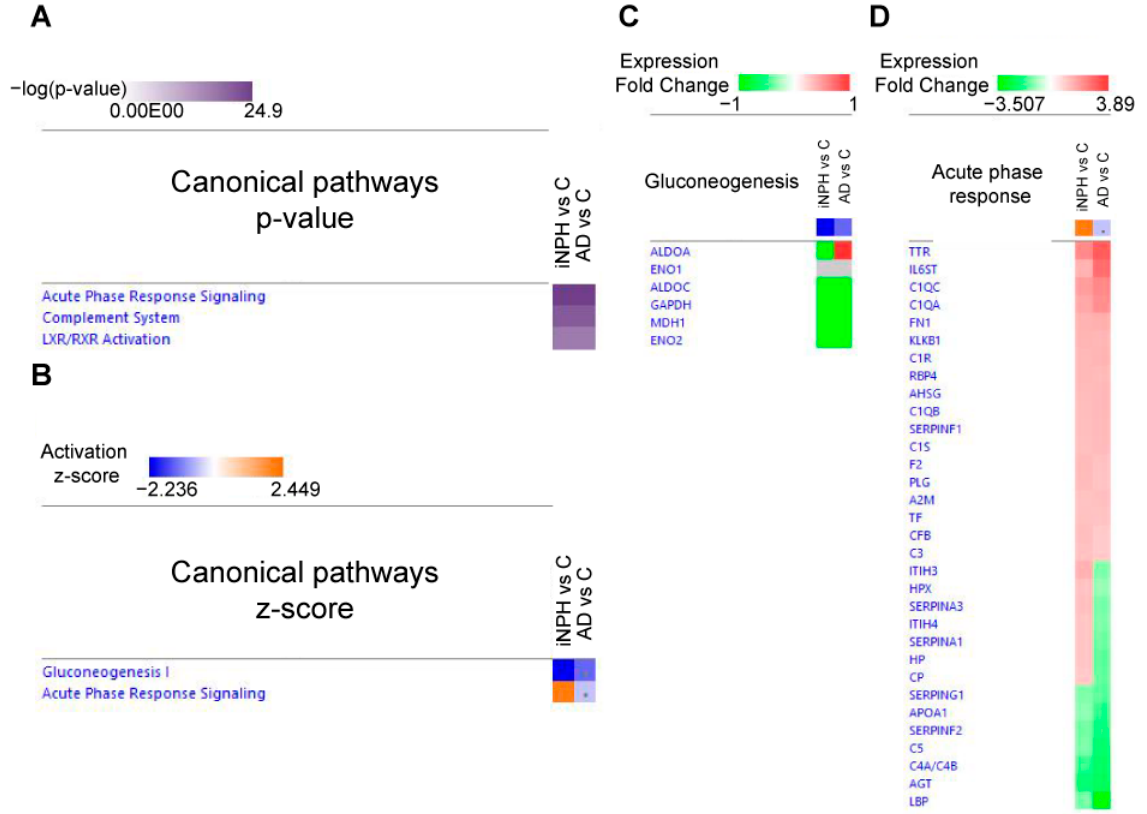
Figure 6. Pathway analysis conducted by IPA software. Canonical pathways were displayed following the p -value ( A ) and the z-score ( B ). Shades of purple from dark to light indicate p -value values from more to less significant. Orange and blue colors indicate pathway activation (orange; z-score > 2) or inhibition (blue; z-score < 2). Dots indicate non-significant z-score. Gene heatmap of protein expression data in gluconeogenesis pathway ( C ) and acute phase response pathway ( D ) was displayed. In the first pathway, fructose-bisphosphate aldolase C (ALDOC), glyceraldehyde-3-phosphate dehydrogenase (GAPDH), MDH1 and gamma-enolase (ENO2) were decreased both in iNPH and in AD, whereas ALDOA was decreased in iNPH and increased in AD (Figure 3c). In acute phase response, inter-alpha-trypsin inhibitor heavy chain H3 (ITIH3), HPX, SERPINA3, ITIH4, SERPINA1, haptoglobin (HP) and CP resulted in being upregulated in iNPH but not in AD (Figure 3d). Green and red colors indicate a decrease or increase in the protein, respectively. Grey color indicates statistically not significant changes.